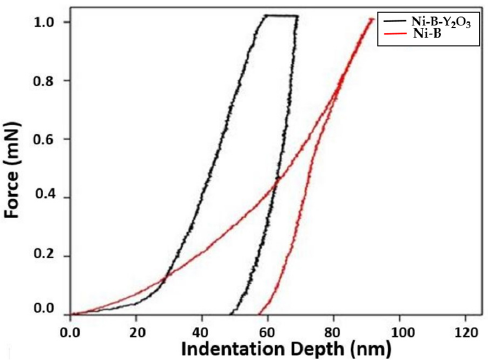
Figure 6. Loading/unloading nanoindentation profiles for Ni ‐ B and Ni ‐ B ‐ Y 2 O 3 electrodeposited composite coatings.